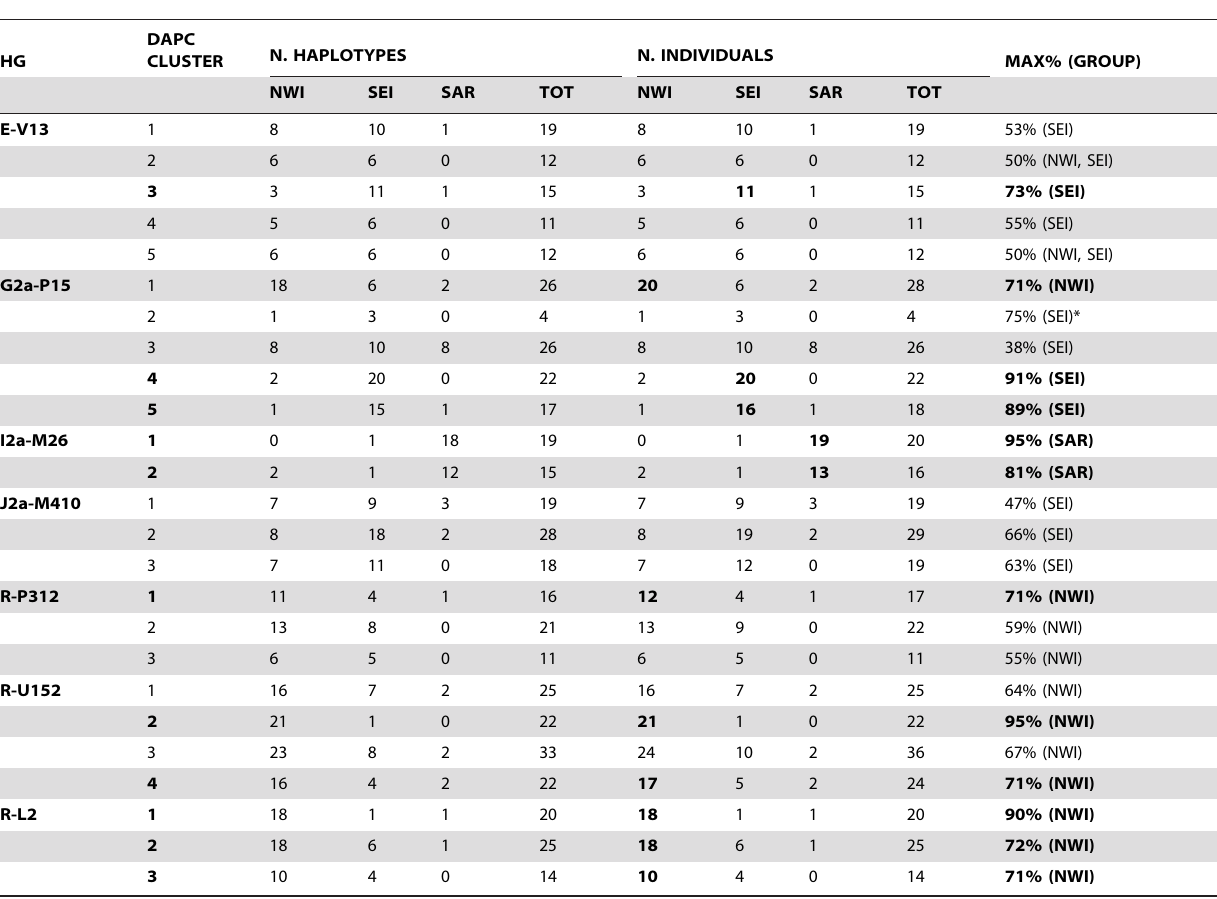
Table 1. Frequencies of Y-Chromosome DAPC cluster for each Italian sPCA-identified group.